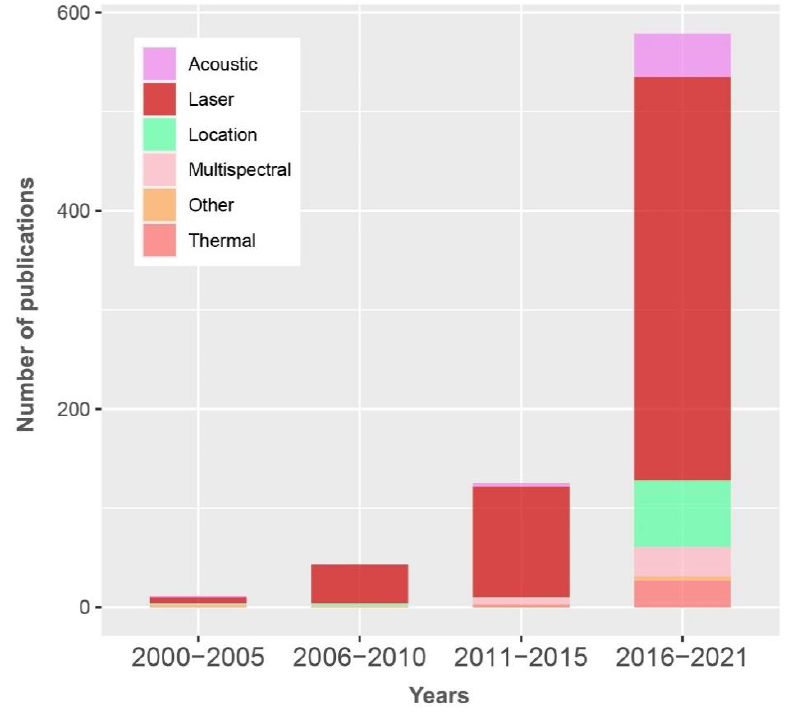
Figure 8. Stacked bar plot showing the number of publications in which photogrammetry was coupled with other techniques during survey activities.